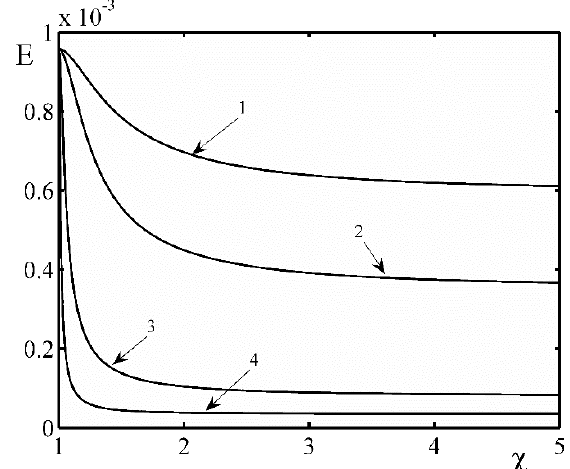
Figure 3: The degree of ellipticity E versus anisotropy factor . curve 1 corresponds to , curve 2 - , curve 3 - , curve 4 - .